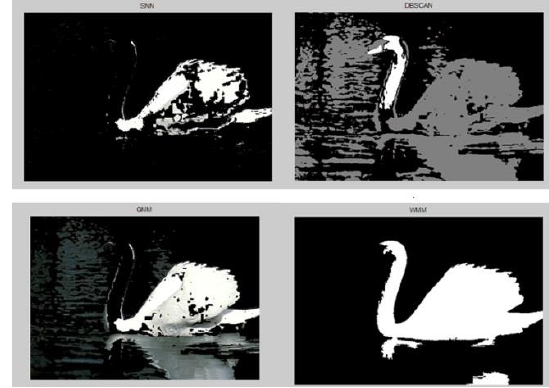
Figure 3. Segmentation results obtained from SNN (Left- top), DBSCAN (Right-top), GMM (Left-down), and WMM